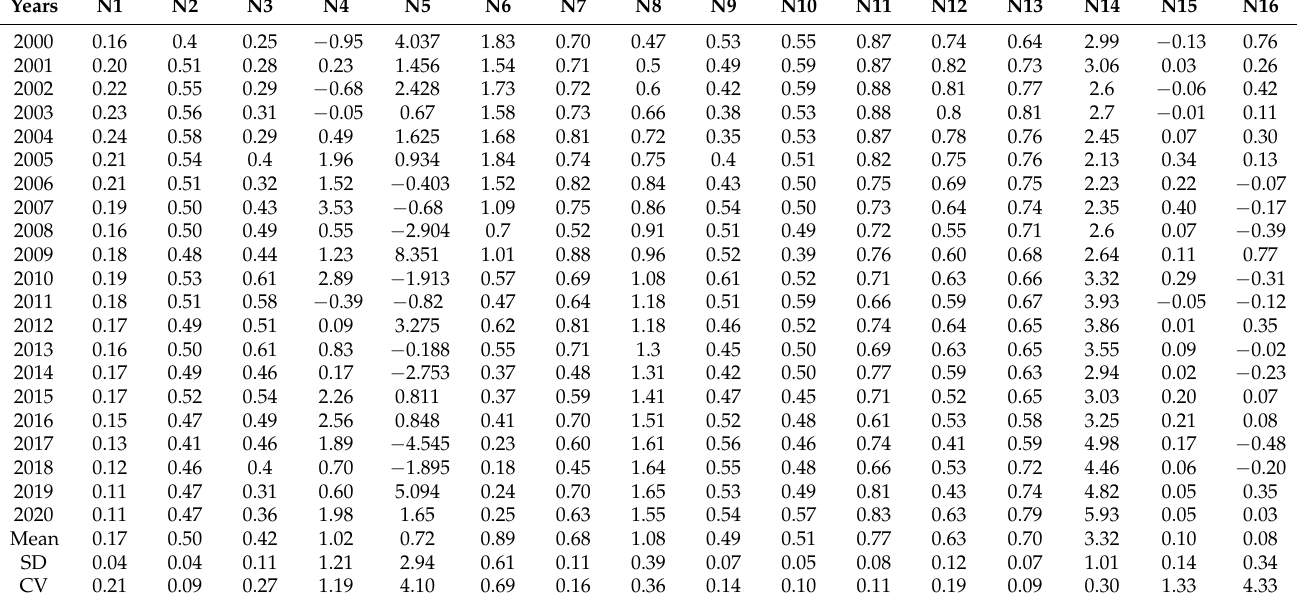
Table 2. Early warning indicators data of the Beijing real estate market from 2000 to